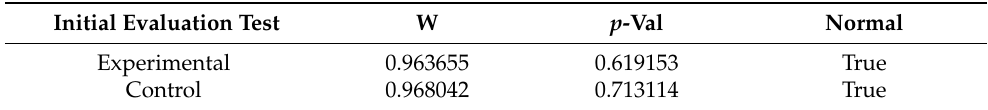
Table 3. Shapiro–Wilk normality test.